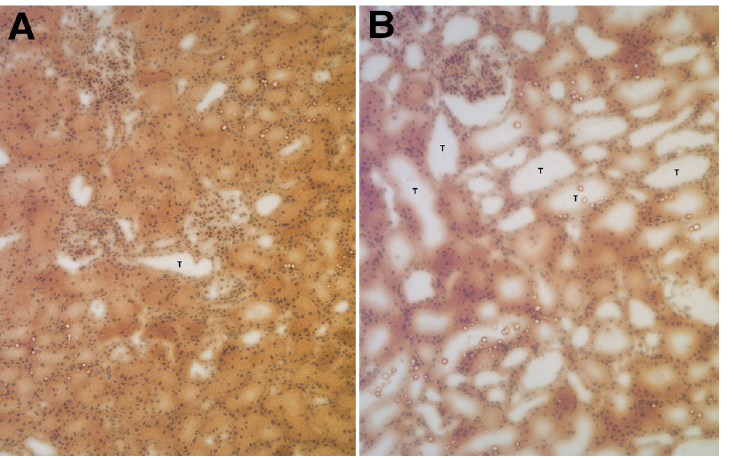
Fig 2. Representative hematoxylin and eosin (H&E)-stained biopsy sections from controls (A) and experimental (cross-clamped) kidneys (B) at 10x magnification. T = tubules. Histologic change in hypoxic kidneys primarily consisted of tubular dilation without associated